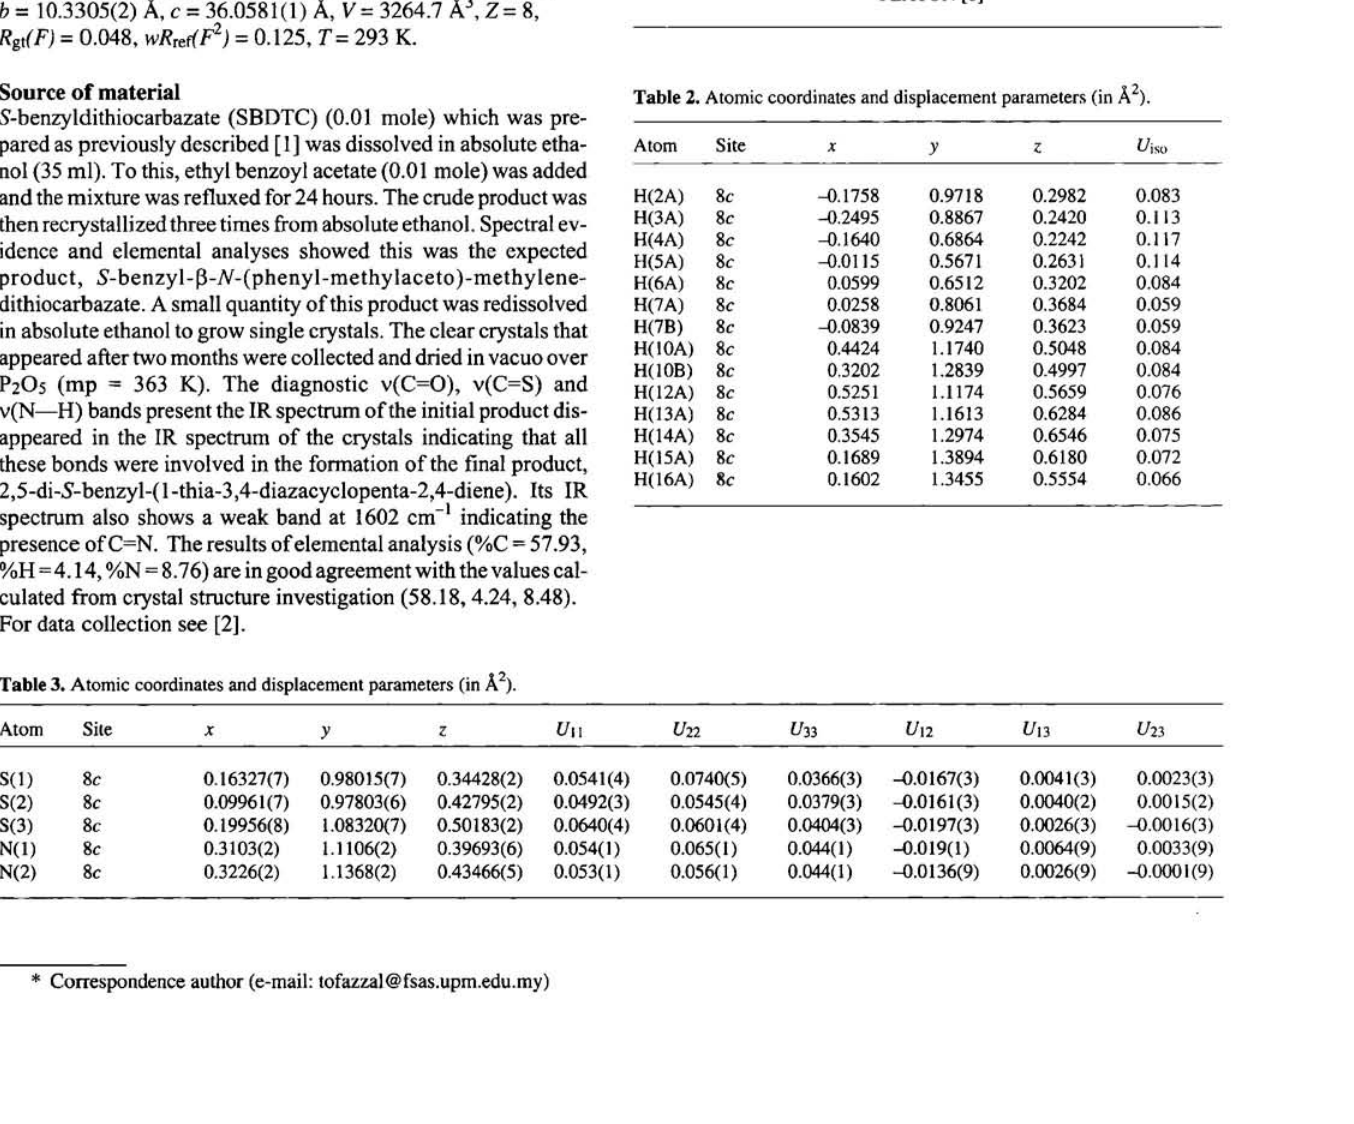
Table 2. Atomic coordinates and displacement parameters (in A 2